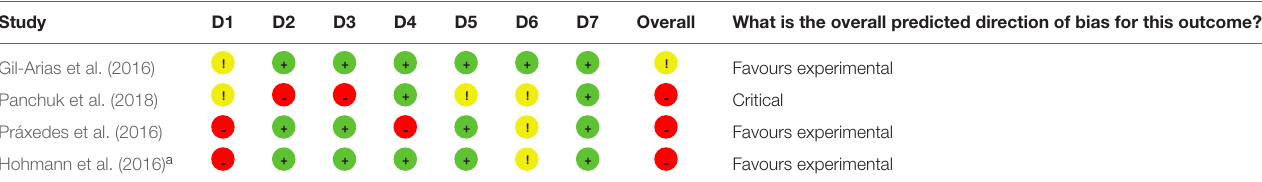
TABLE 5 | Assessment of ROBINS-I.